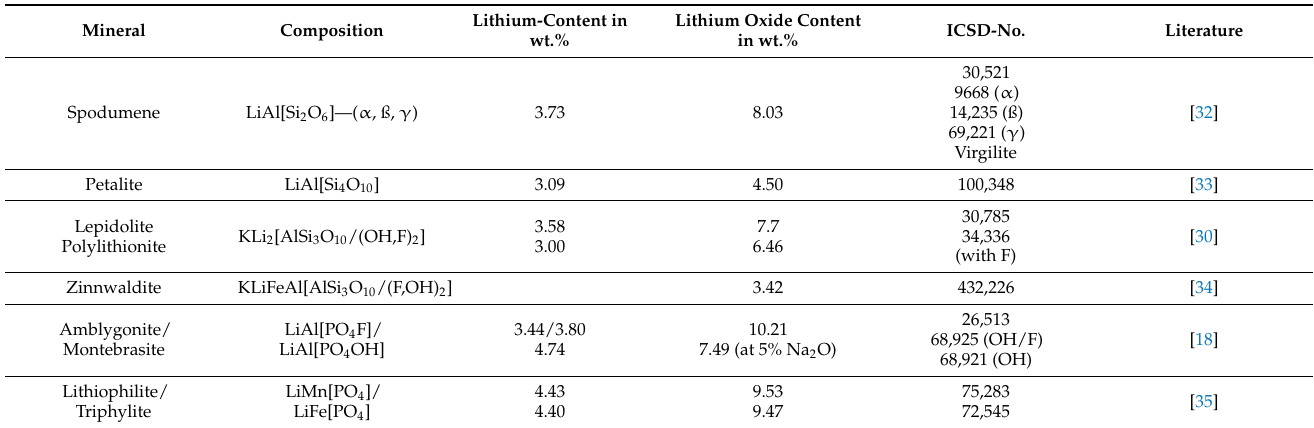
Table 1. Important lithium-bearing minerals, compositions and crystal structure